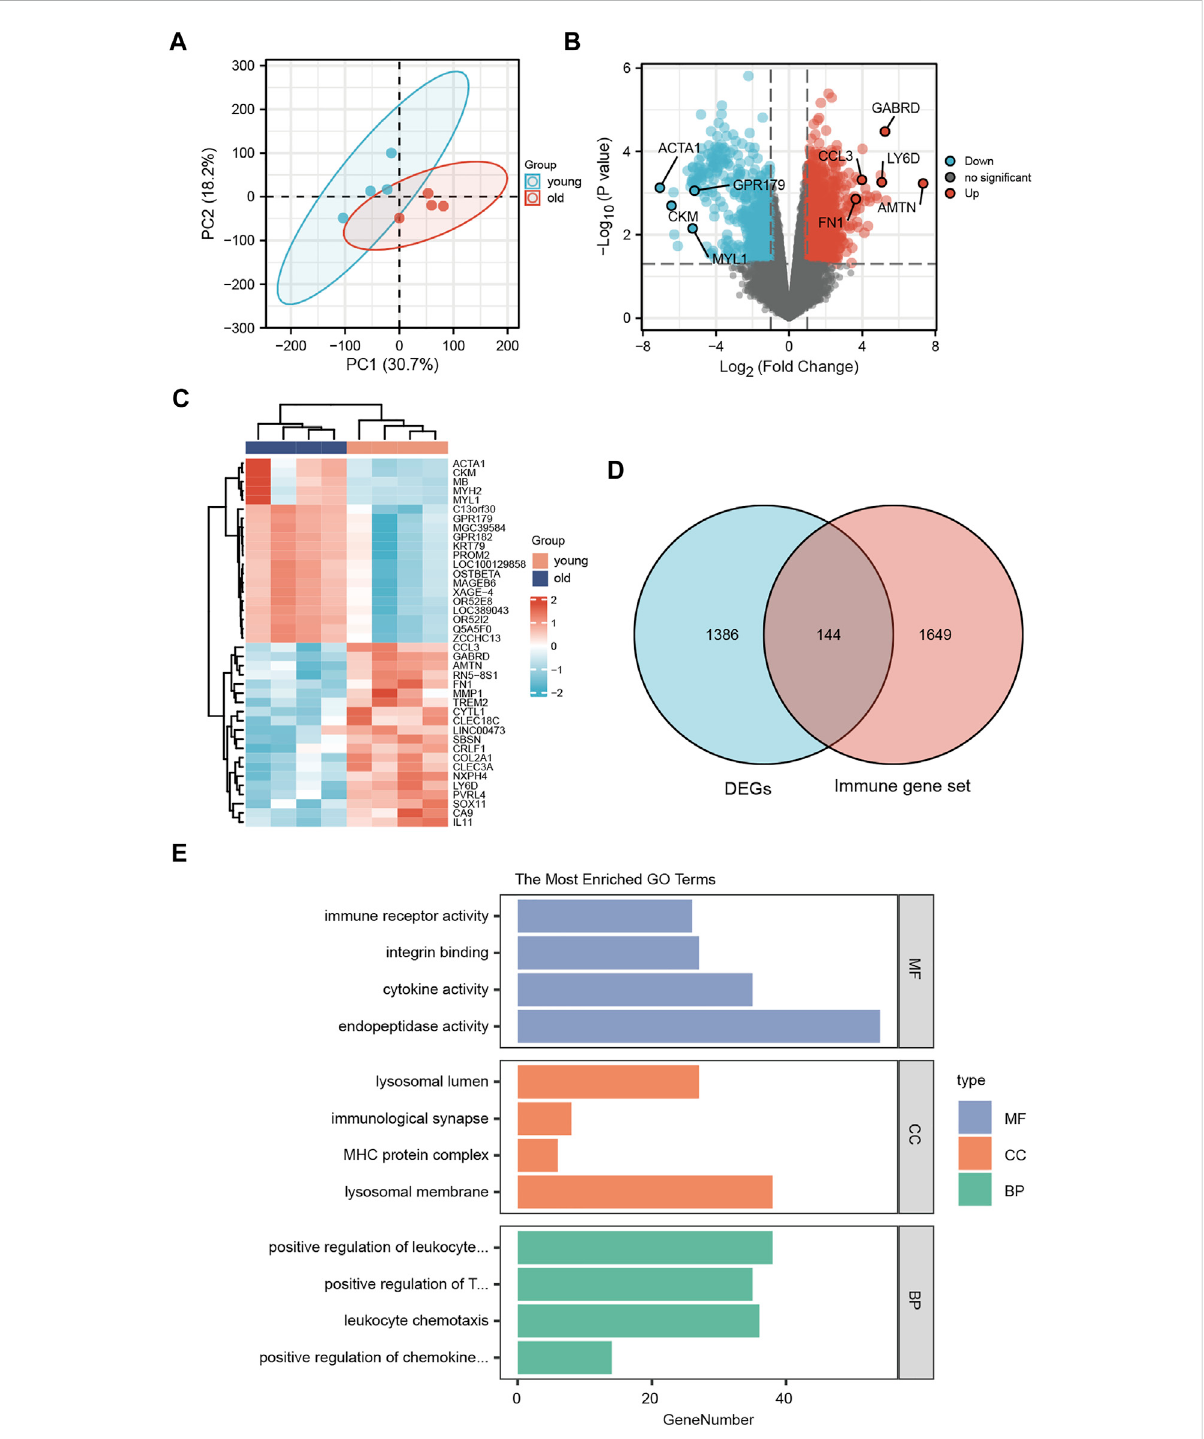
FIGURE 4 Differentially expressed genes. (A) Principal component analysis of the GSE113212 dataset. (B) Horizontal coordinates are log2FC, vertical coordinates are − log10 (adjusted p); red nodes indicate upregulated genes, blue nodes indicate downregulated genes, gray nodes indicate genes that are not signi fi cantly differentially expressed. (C) Horizontal coordinates are patient ids, vertical coordinates are their DEGs; red represents genes with high expression, blue represents genes with low expression, pink annotation bar indicates young normal LF group, blue annotation bar indicateselderlyLFHgroup. (D) BluecirclesindicateDEGsinGSE113212, pinkcirclesindicate immune-related genesets; theintersectionshowsLFH immune-related DEGs. (E) GO functional enrichment analysis; vertical coordinates are the various GO terms enriched for DEGs, and horizontal coordinates are the number of DEGs enriched in each GO